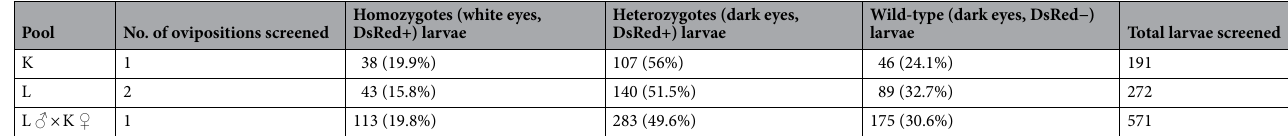
Table 2. Genotype frequencies arising from sibling crosses. Heterozygotes from pools K and L were sibling crossed and their offspring screened for inheritance of the transgene as well as eye color phenotype as late